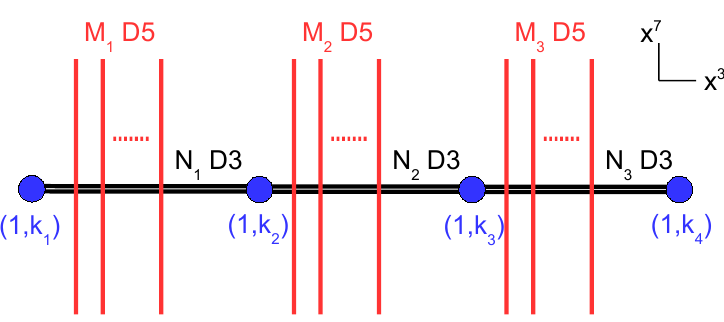
Figure 2 . Brane con(cid:12)guration realizing a general N = 3 linear quiver with three nodes, in the ( x 3 ; x 7 )